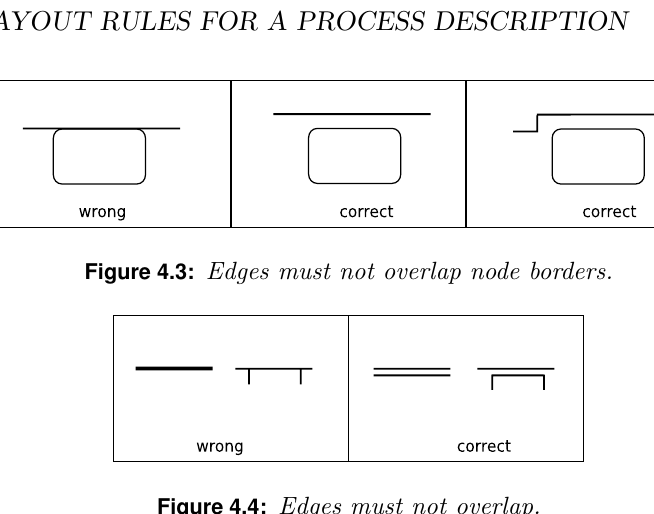
Figure 4.4: Edges must not overlap.